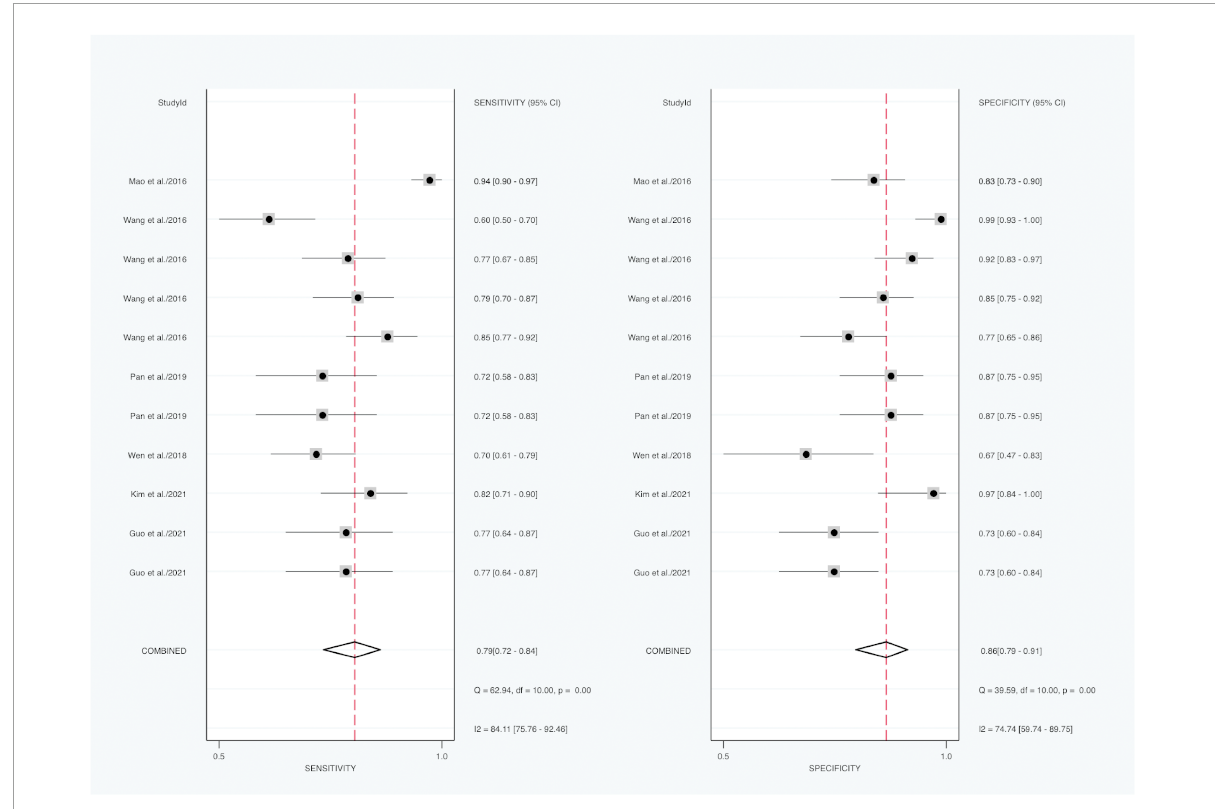
FIGURE4 Forest plots of sensitivity and specificity of SF in the diagnosis of KD (KD vs.